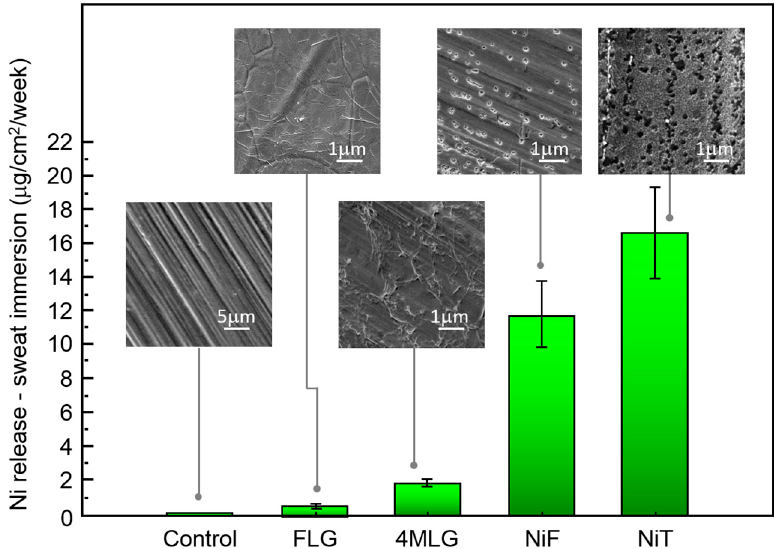
Figure 5. Ni ion release from graphene-coated samples exposed to artificial sweat. ICP measurements on grown and transferred graphene-coated and uncoated Ni samples after 1 week of sweat immersion showing Ni dissolution. Uncoated samples (NiT and NiF) in contact with sweat present highest Ni ion release. All samples where 1 cm 2 . SEM images show morphology of samples after sweat exposure.